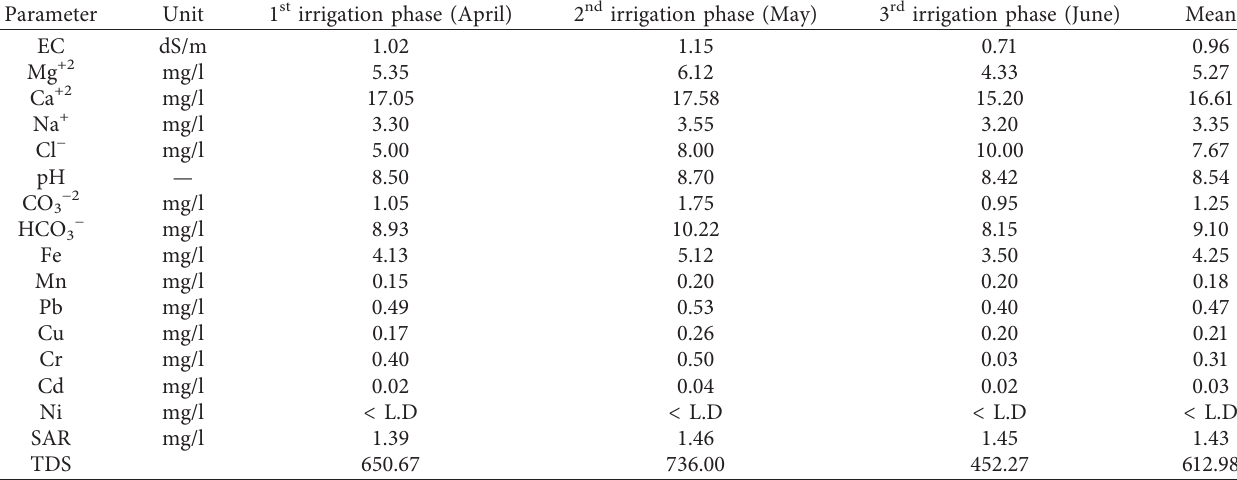
Table 2: Physicochemical characteristics of downstream Borkena water quality in different irrigation phases.